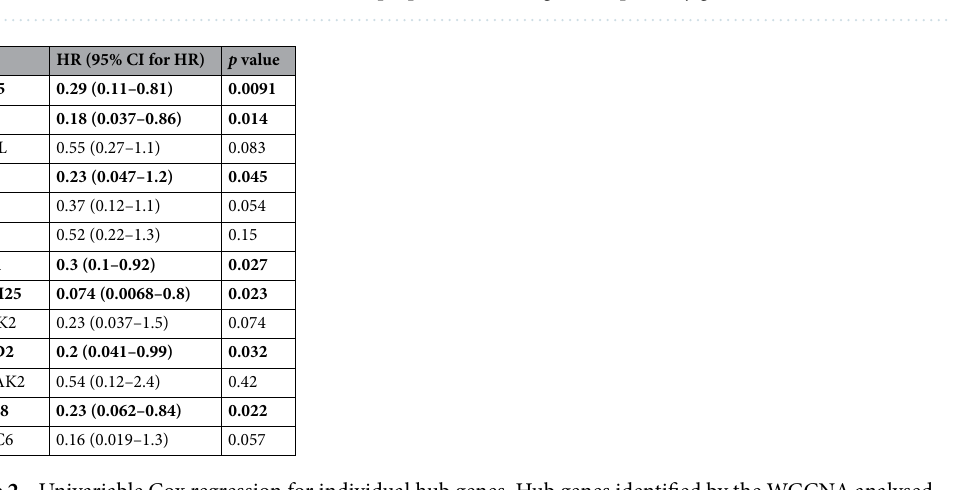
Figure 2. Protein Interactions and Pathways Enrichment for genes protective for viral rebound. ( A ) Visualisation of the Protein–Protein Interaction network of key genes within Module 1 using STRING for cross- validation of hub genes identified through GS and MM scoring. ( B ) Pathways enrichment bar plot identified using STRING and the Reactome database. The proportion of hub genes to pathway genes is shown on x-axis.